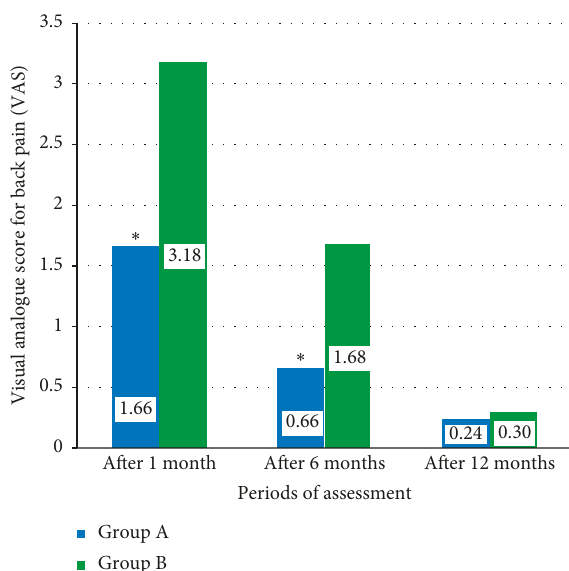
Figure 2: The mean differences of the postoperative visual analogue index (VAS) for back pain between study groups.